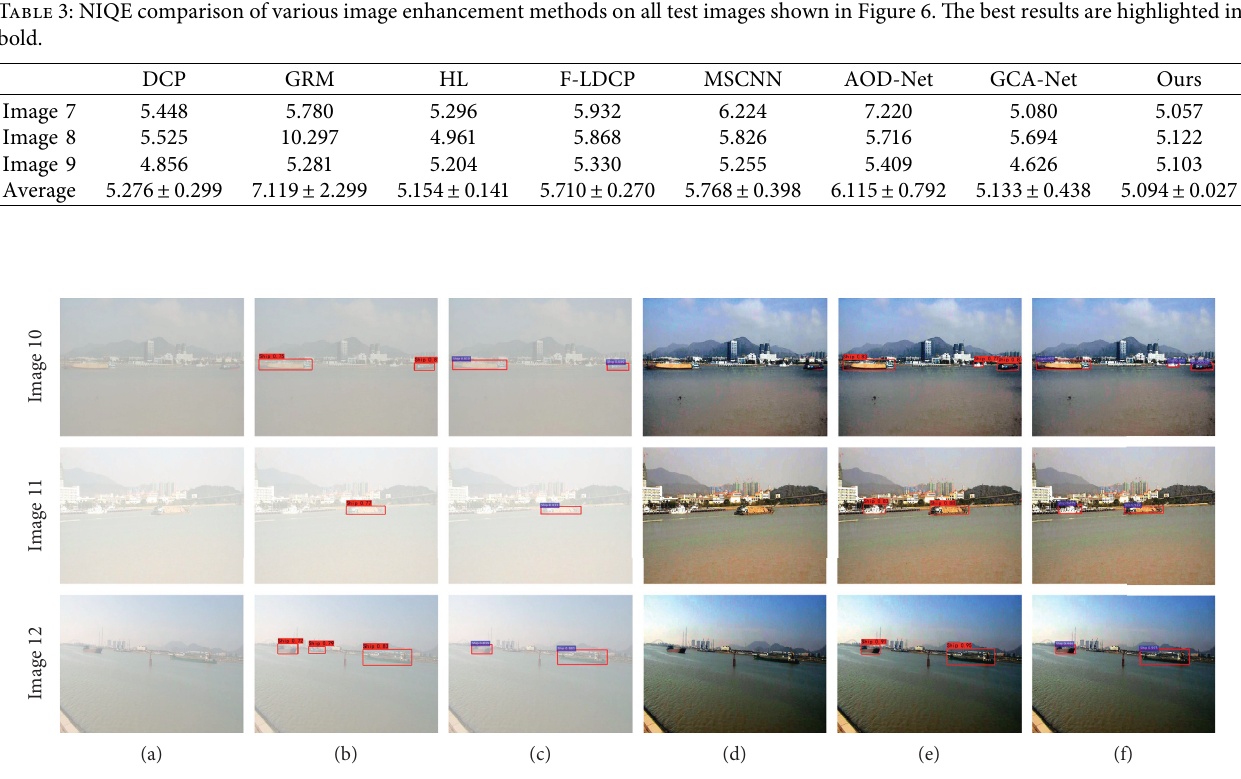
Figure 9: Vessel detection experiments under haze environment. (a) Hazy image, (b) hazy image (YOLOv4), (c) hazy image (Faster- RCNN), (d) dehazed image, (e) dehazed image (YOLOv4), and (f) dehazed image